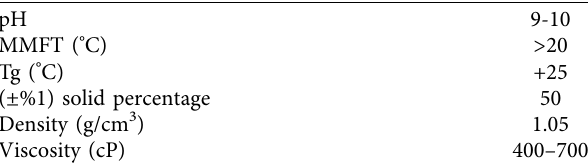
Table 4: Some properties of acrylic resin